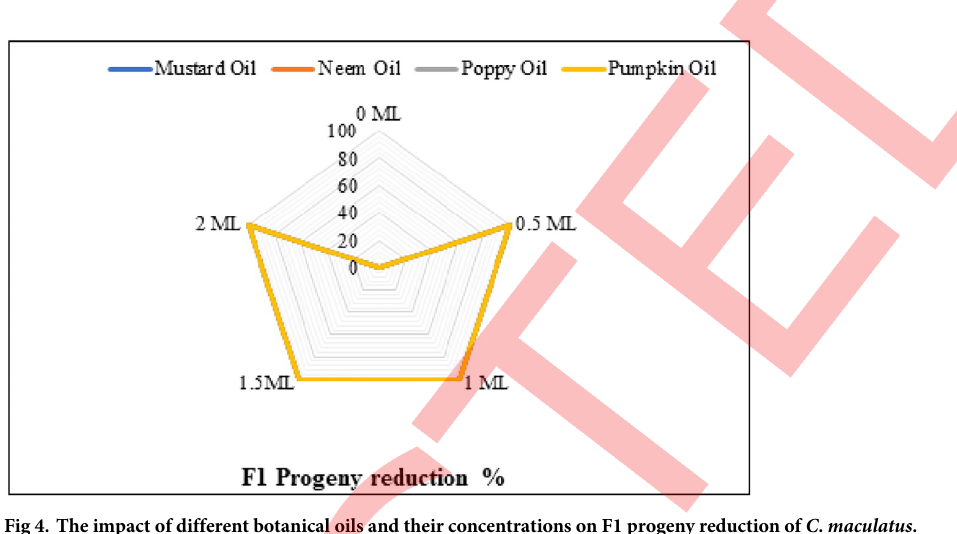
Fig 4. The impact of different botanical oils and their concentrations on F1 progeny reduction of C . maculatus .